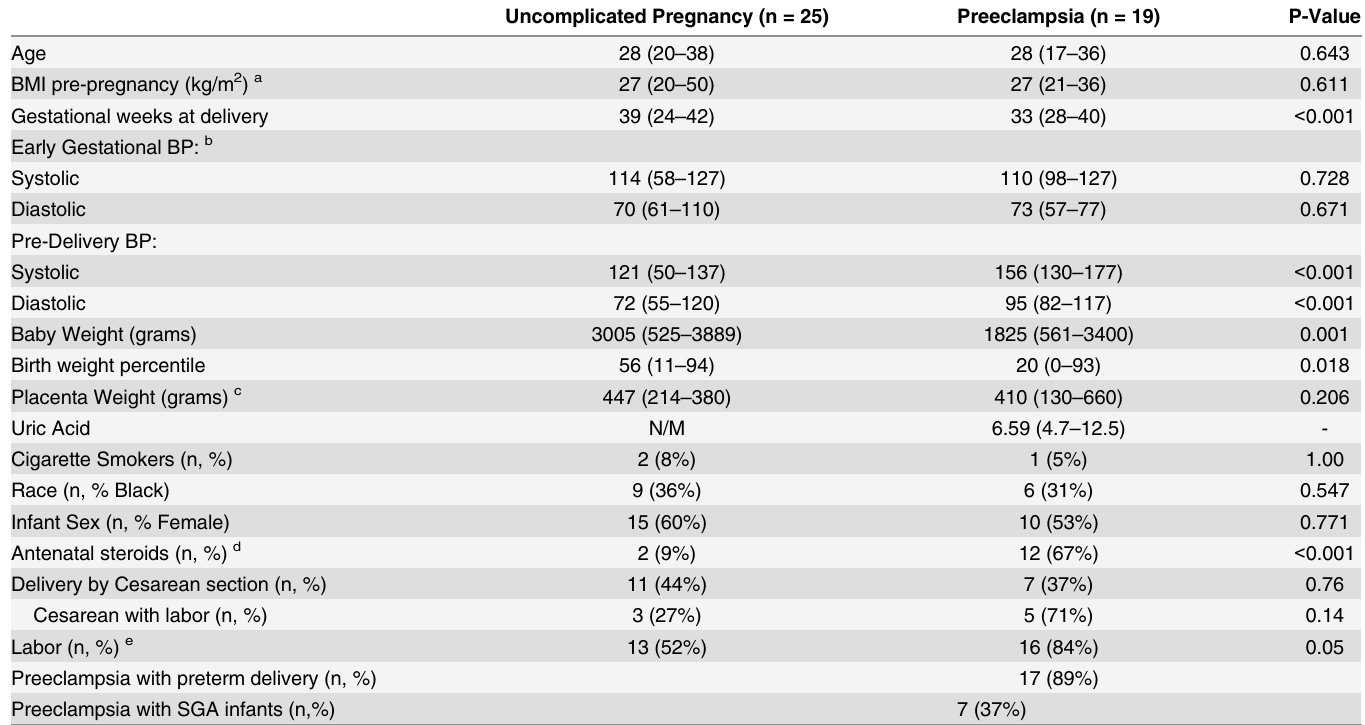
Table 2. Clinical characteristics of uncomplicated pregnancy (n = 25) and preeclampsia (n = 19) groups for placental